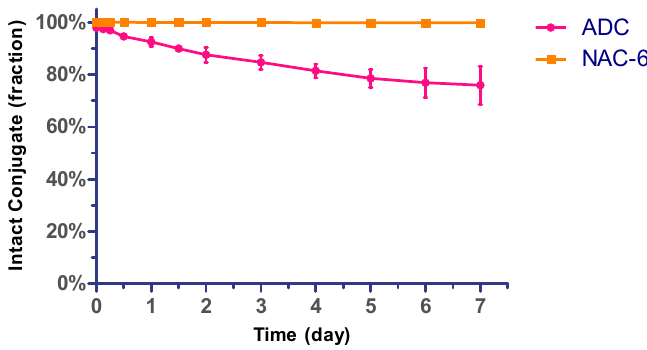
Figure 3. Stability assays of silyl ether-based ADC (mil40-6) and its payload conjugate (NAC-6) in human plasma. ADC and NAC-6 were incubated at 37 °C for 7 days. Error bars represent standard deviation from three independent experiments (triplicates). Results are shown as the mean ± SD. NAC: N -acetyl- L -cysteine.